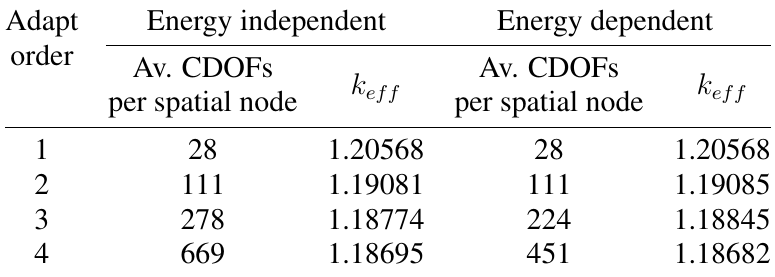
Table 1: Comparisson of average number of Continuous (CDOFs) per adapt step with the use of energy dependent angular discretisations for all 7 energy groups, using a reference value 1 . 18655 . The energy dependent angular discretisation results in 32% less the